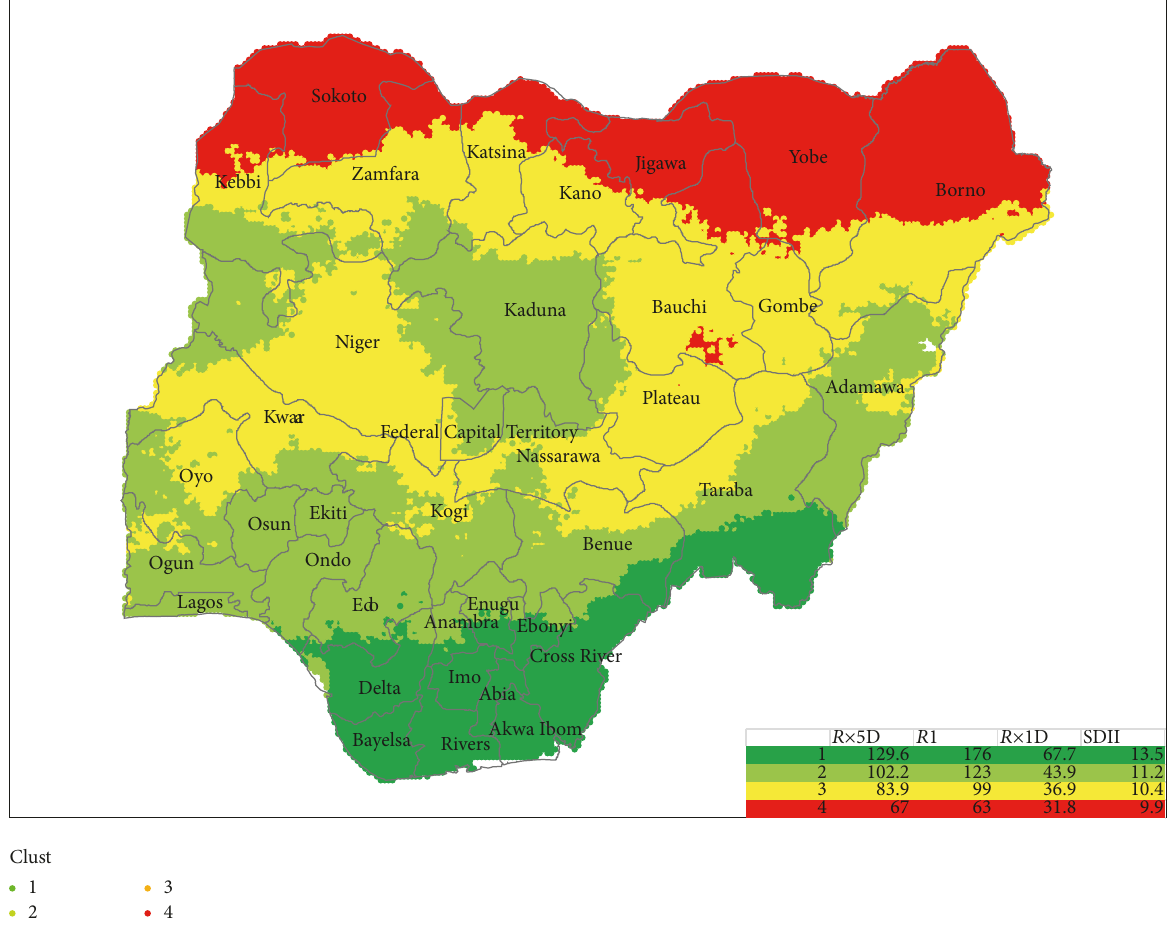
Figure 5: Precipitation indices clustering over Nigeria in 2003.